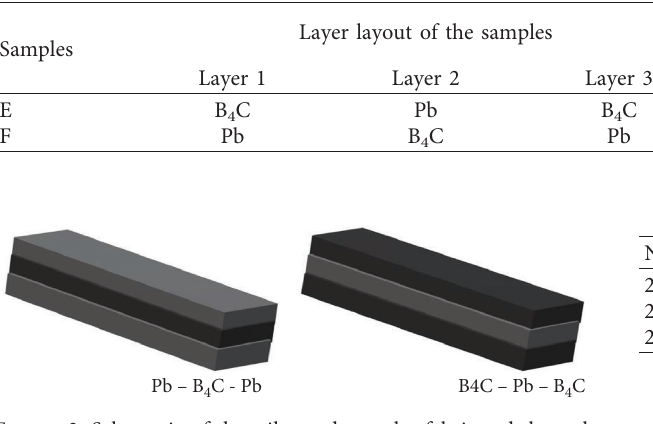
Figure 2: Schematic of the trilayered samples fabricated through layered molding and